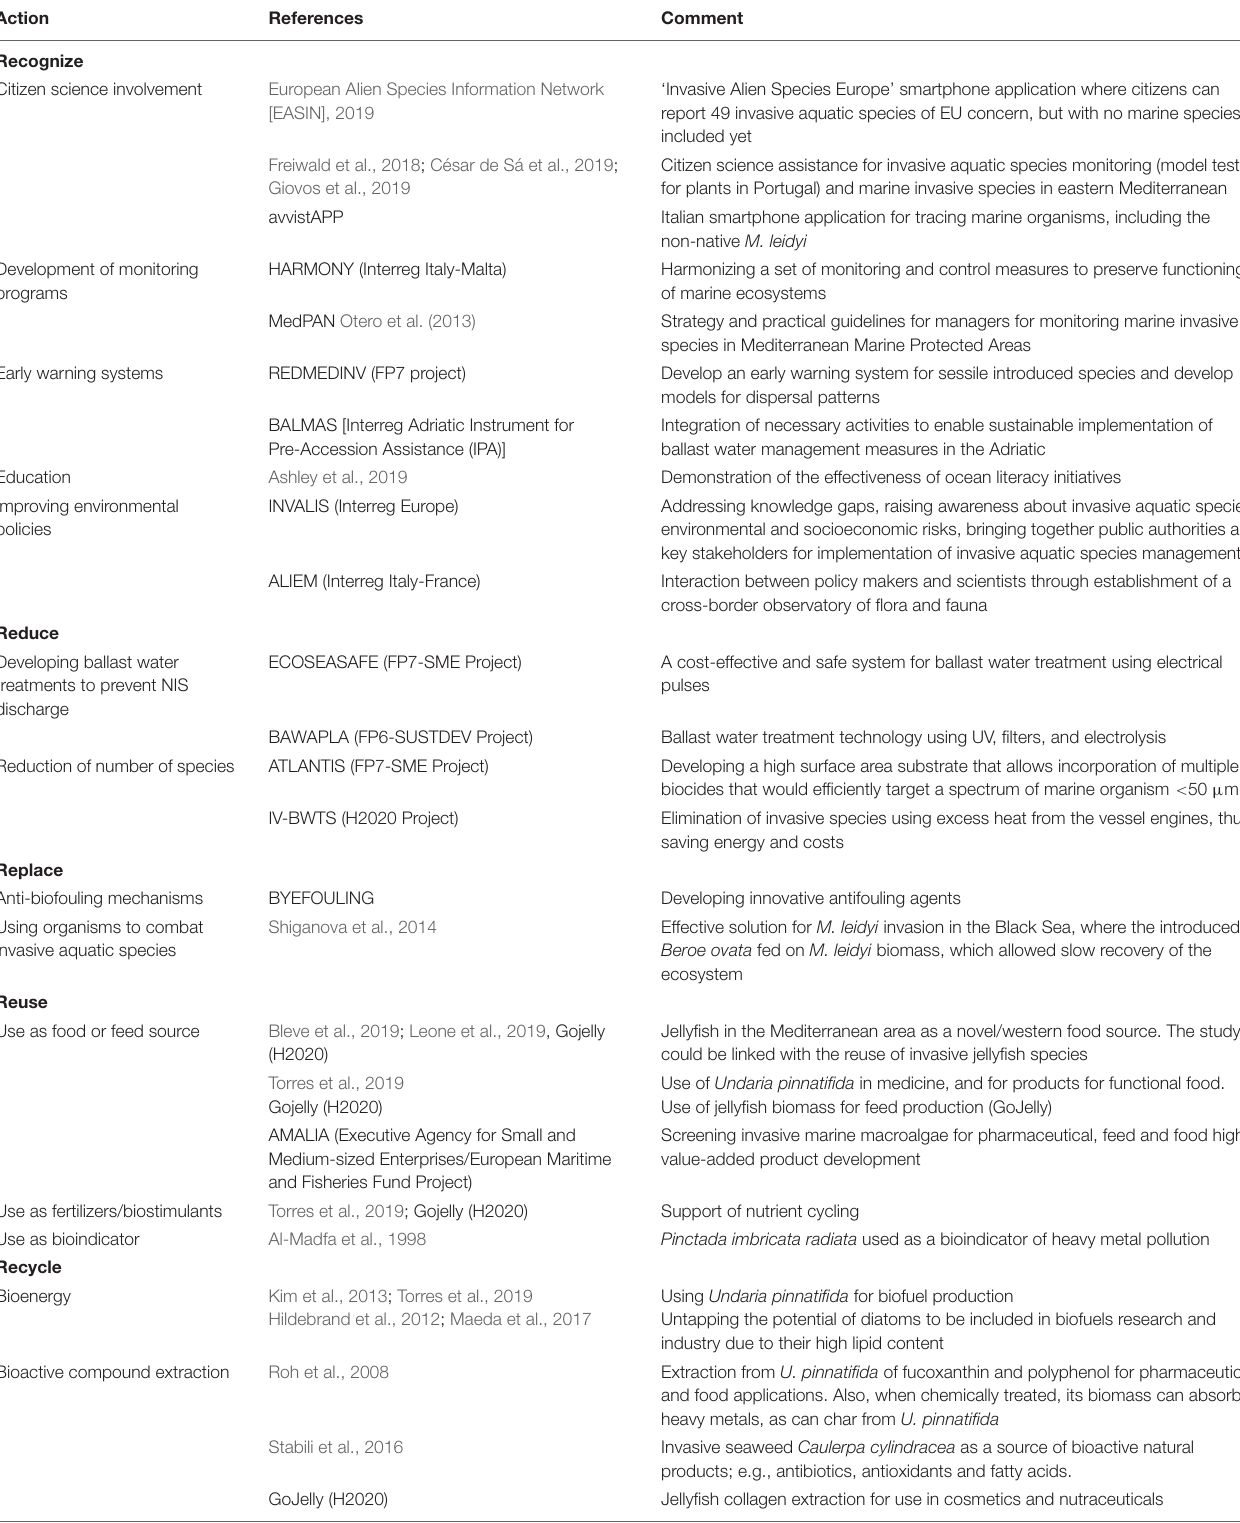
TABLE 1 | Innovative solutions under the 8Rs categories that are designed to mitigate the problems of non-indigenous species.